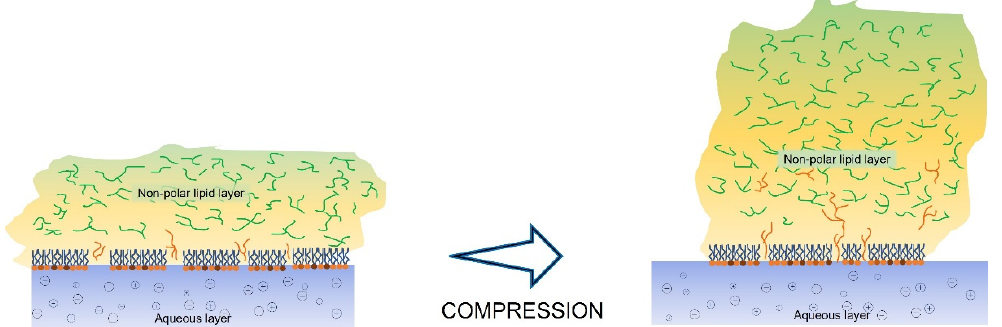
Figure 7. A simplified figure of the redistribution of sesame oil’ GS2U and GS3U (G—glyceride backbone, U—unsaturated and S—saturated acyl chain respectively) triglycerides between the polar and non-polar fractions of the TFLL; compression engender their climbing into the NPL stratum (see main text for details).